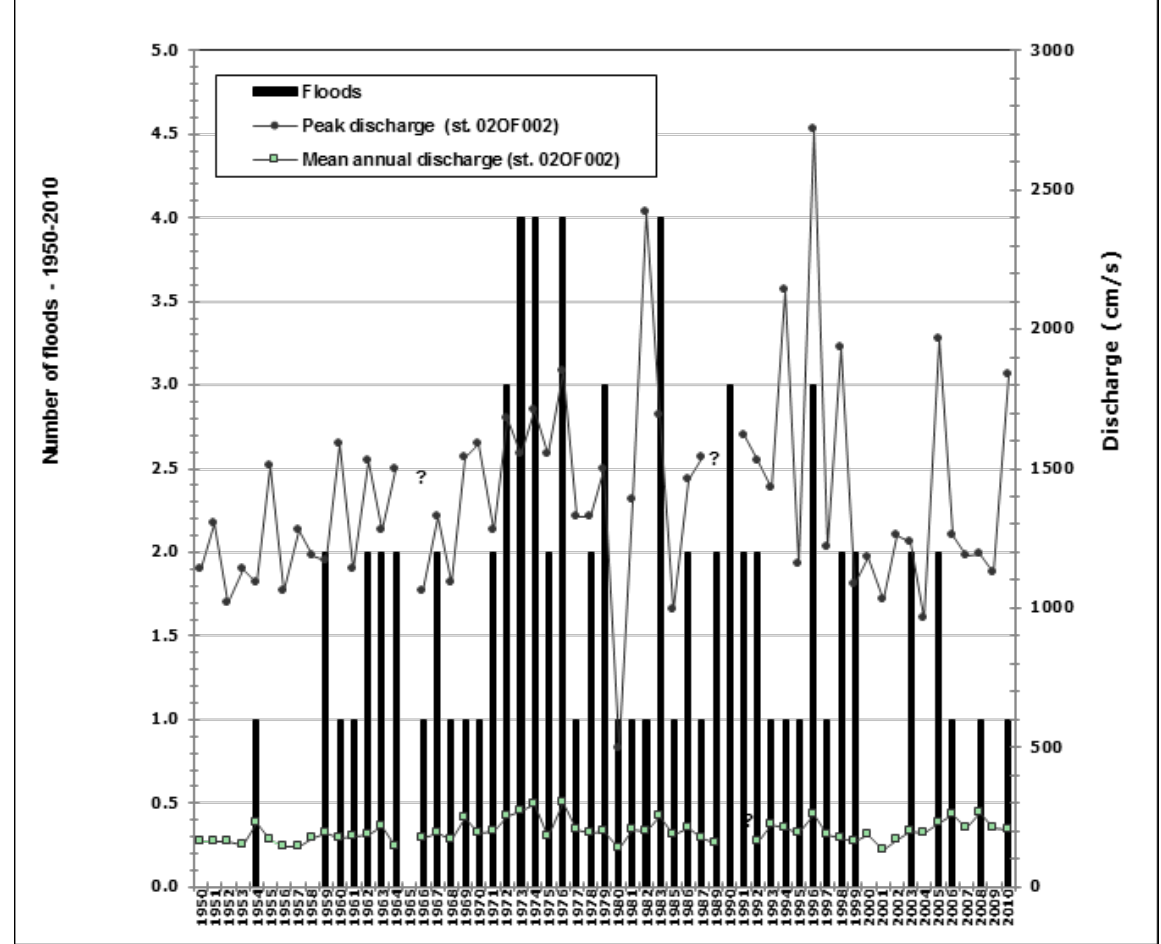
Figure 2. Flood time series for the period between 1950 and 2010 for the Saint-François River basin based on flow records from gauging station (02OF002) at